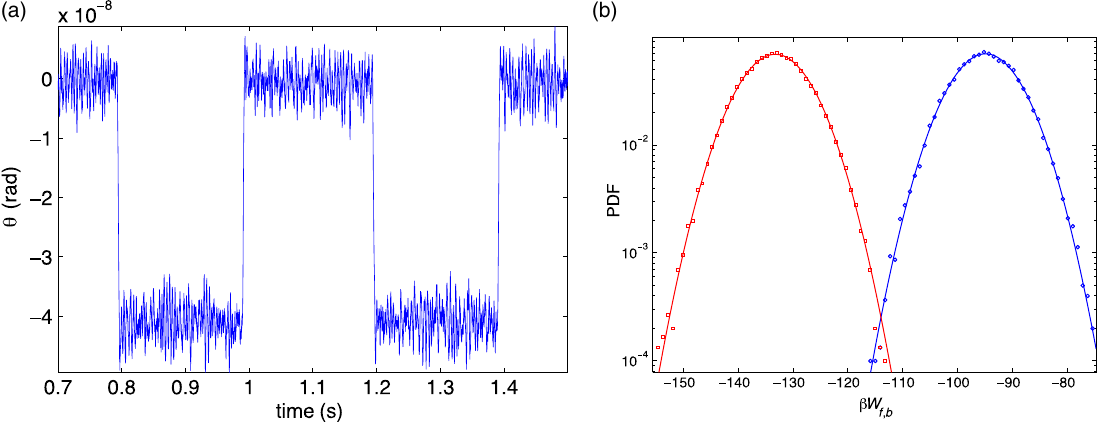
FIG. 6. Free-energy measure in the harmonic oscillator. (a) Time evolution of θ ð t Þ under a periodic torque M which drives the Þ ¼ 4 . 1 nrad] and vice versa. In this specific case the stiffness is C ≃ 5 . 5 Nm, the transition time is oscillator from A ( θ ¼ 0 ) to B [ θ ð t s ≃ 0 . 1 τ ¼ 22 . 4 Nm rad − 1 . (b) Probability distribution functions of the work for the forward (blue curve) and backward t , and M s o relax (red curve) transformation. The crossing point of the two PDFs determines the value of Δ F T , which is within experimental errors of the expected theoretical Δ W ¼ − 112 k B